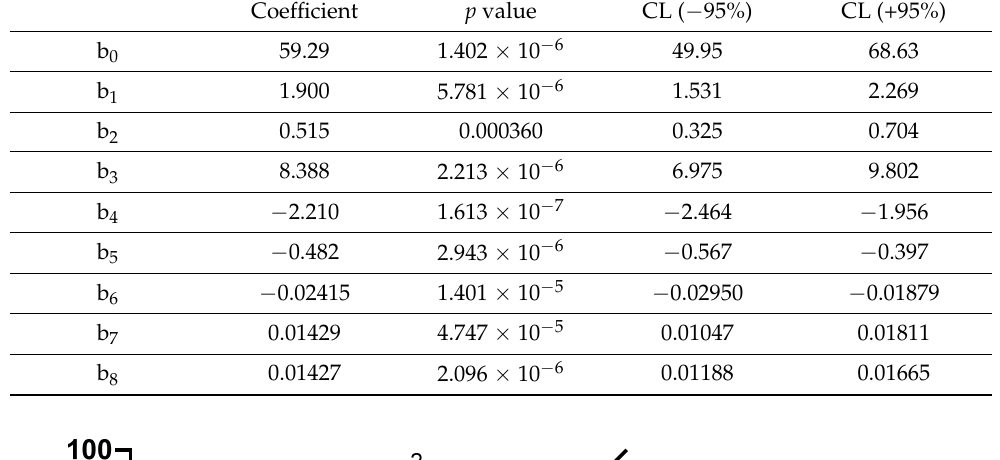
Table 2. Polynomial equation describing the percentage of Anisakis survivability ( S ) treated in water solution after PEF treatments of different electric field strength (E), specific energy (W), and pulse width (P). Statistical significance ( p value) and the 95% confidence limits of each parameter is included.